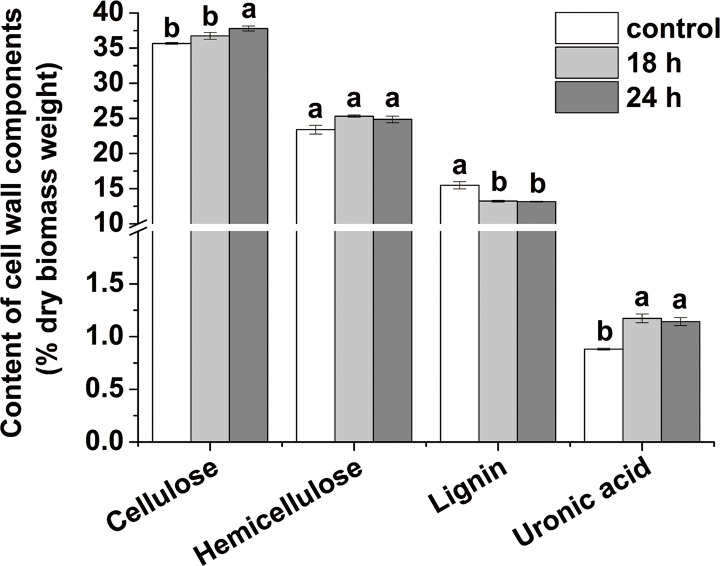
Content of cell wall components in switchgrass stem.The different small letters or capital letters in each group of columns indicate the significant difference at level of P < 0.05 or 0.01, respectively. The bar indicates SE (n = 5).